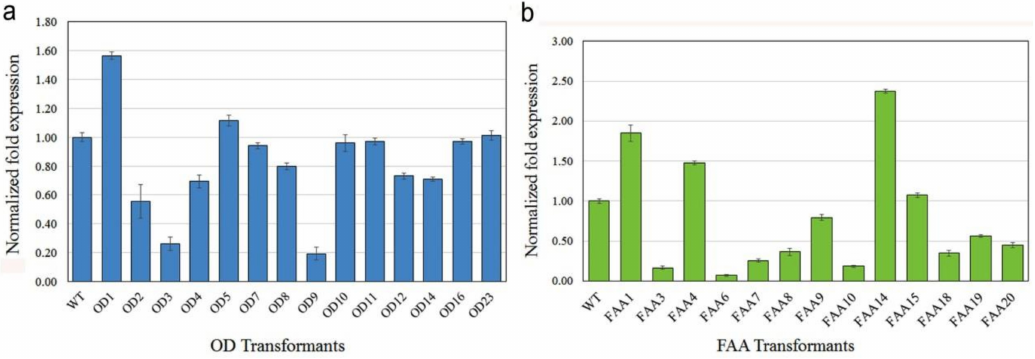
Figure 7. Quantitative real-time PCR analysis in transgenic plants. ( a ) OD mRNA expression in leaf tissue of transgenic OD plants. ( b ) FAA mRNA expression in leaf tissue of transgenic FAA plants. The results from three or more independent experiments are presented as mean ± S.D. (standard deviation).